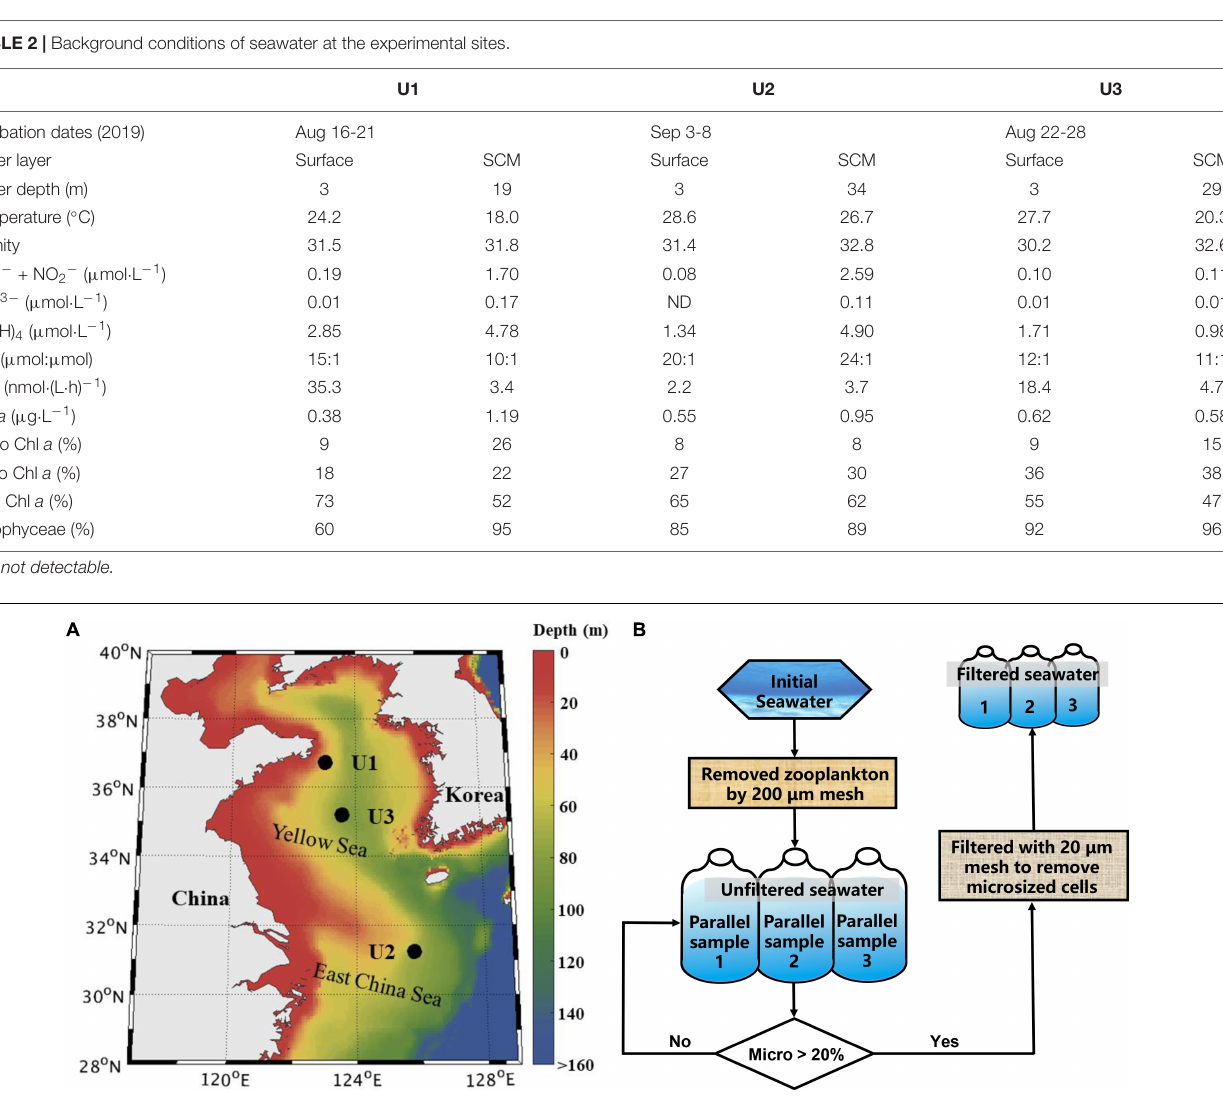
FIGURE 1 | Water sampling stations used for the microcosm incubation experiments in the Yellow Sea and East China Sea (A) and the treatment procedure of the incubations (B) . Where micro refers to the contribution of microsized Chl a to total Chl a .